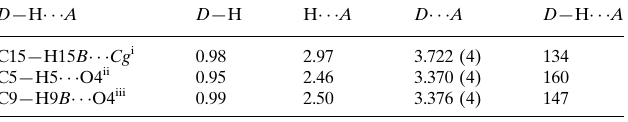
Hydrogen-bond geometry (A˚ , (cid:2)